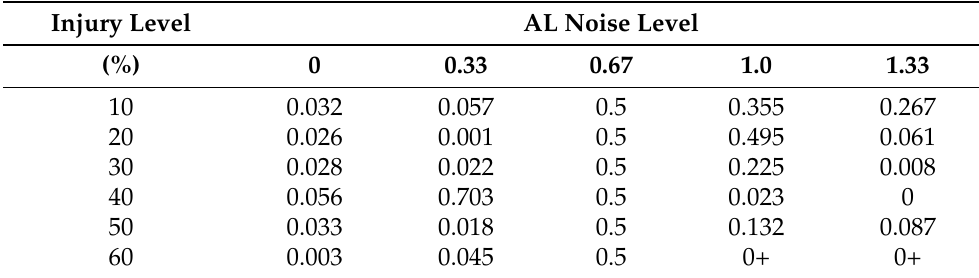
Table A2. P -values for normalized post-injury effects of increased AL noise on average responses (see Figure 7C). p -values are much larger than those corresponding to top-scoring responses (cf. Table A1), indicating weaker protective effects. p -values are for a given AL noise vs. AL noise = 0.67 (i.e., the middle value). “0+” indicates p -value < 0.0005. N = 98 to 112 (mean = 107).